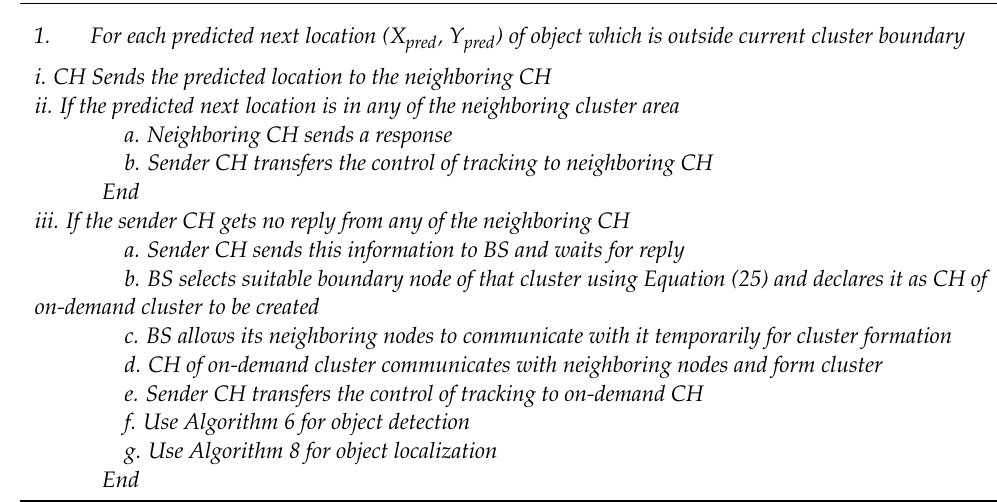
Algorithm 9 : On-demand cluster creation for tracking.